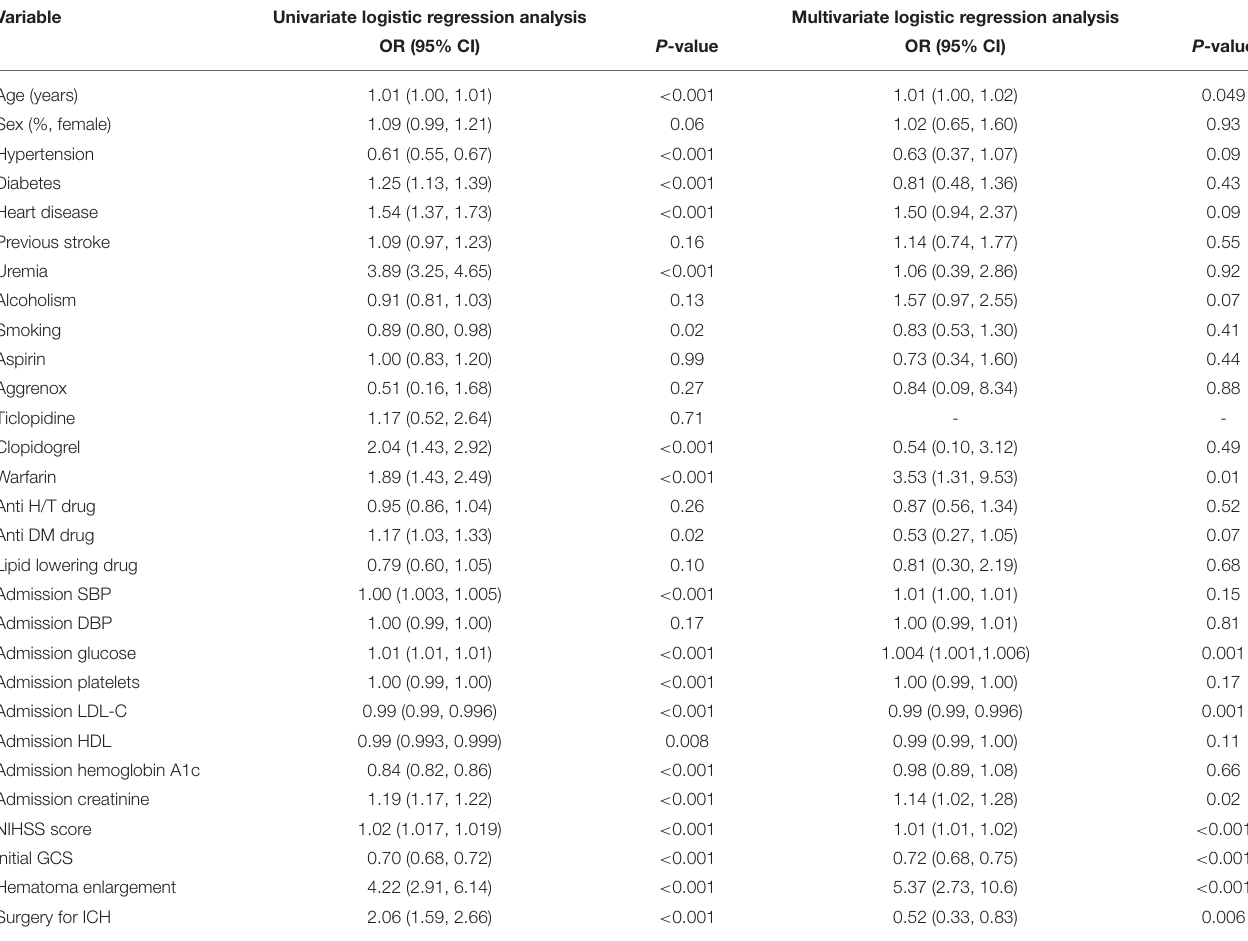
TABLE 6 | Univariate and multivariate logistic regression analyses evaluating the association of baseline characteristics with the likelihood of 3-month mortality.